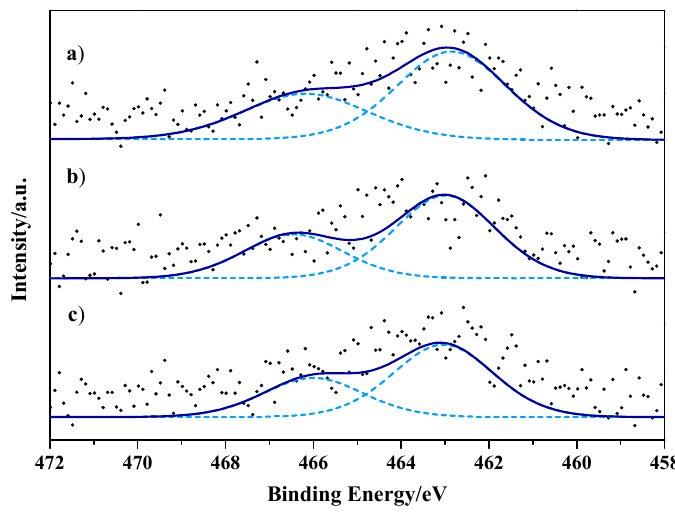
Figure 4. Ru 3p XPS spectra of samples ( a ) Ru-T, ( b ) Ru-TSu, and ( c ) Ru-TS. Table 5. Binding energy of Ru 3p and proportion of the two Ru species (in brackets).